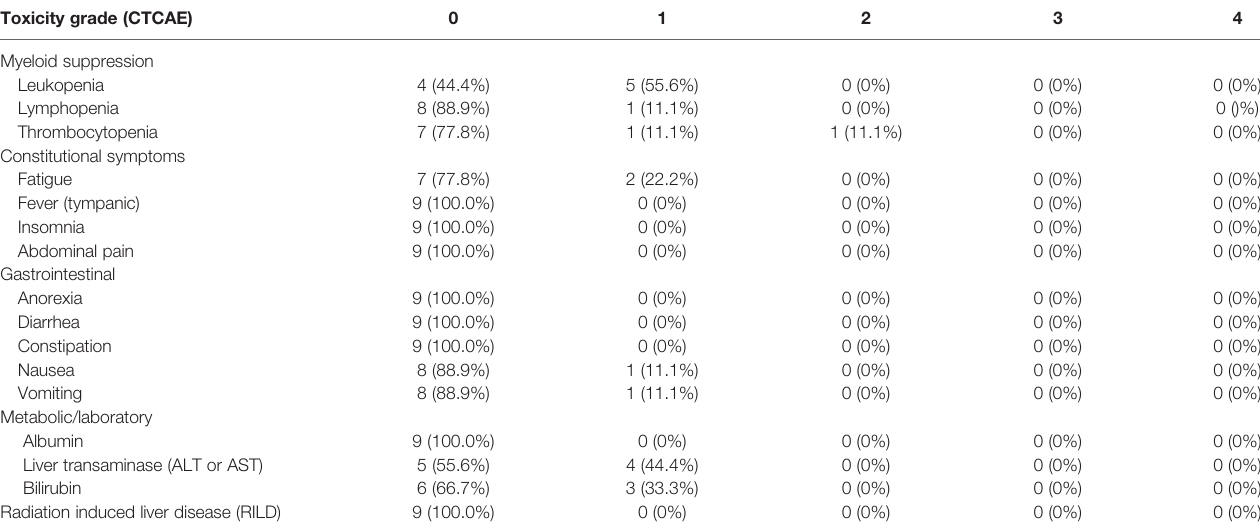
TABLE 5 | Toxicity from stereotactic body radiotherapy (SBRT) in patients with positive margin. Toxicity grade (CTCAE) 0 Myeloid suppression Leukopenia